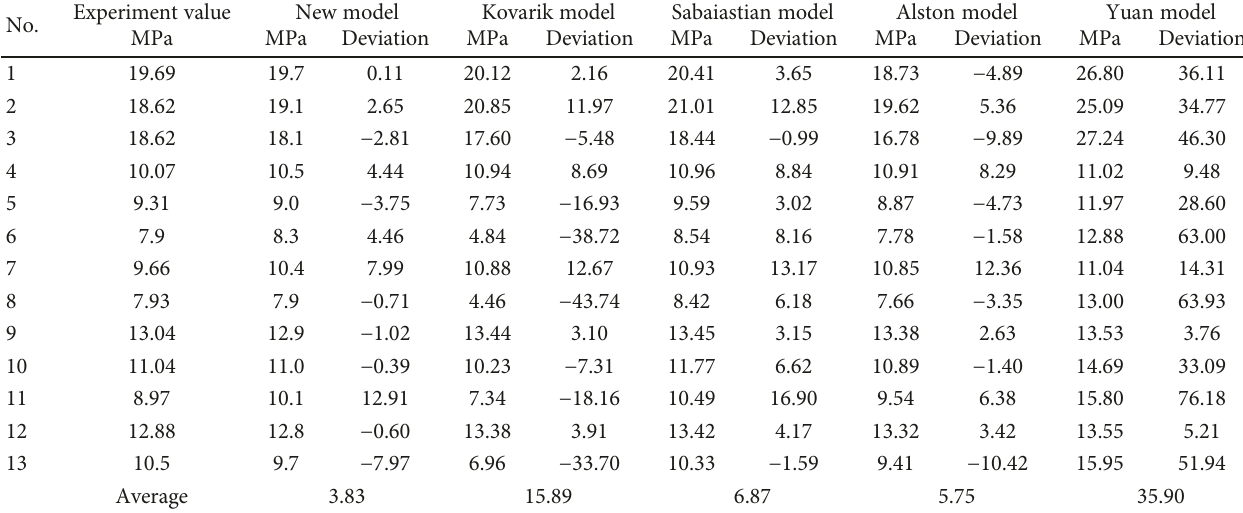
Table 6: Results of MMP forecasting model.